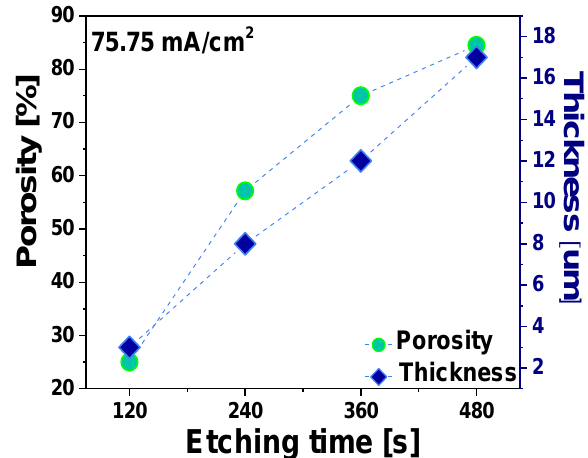
Figure 2. Porosity and thickness as a function of the etching time.